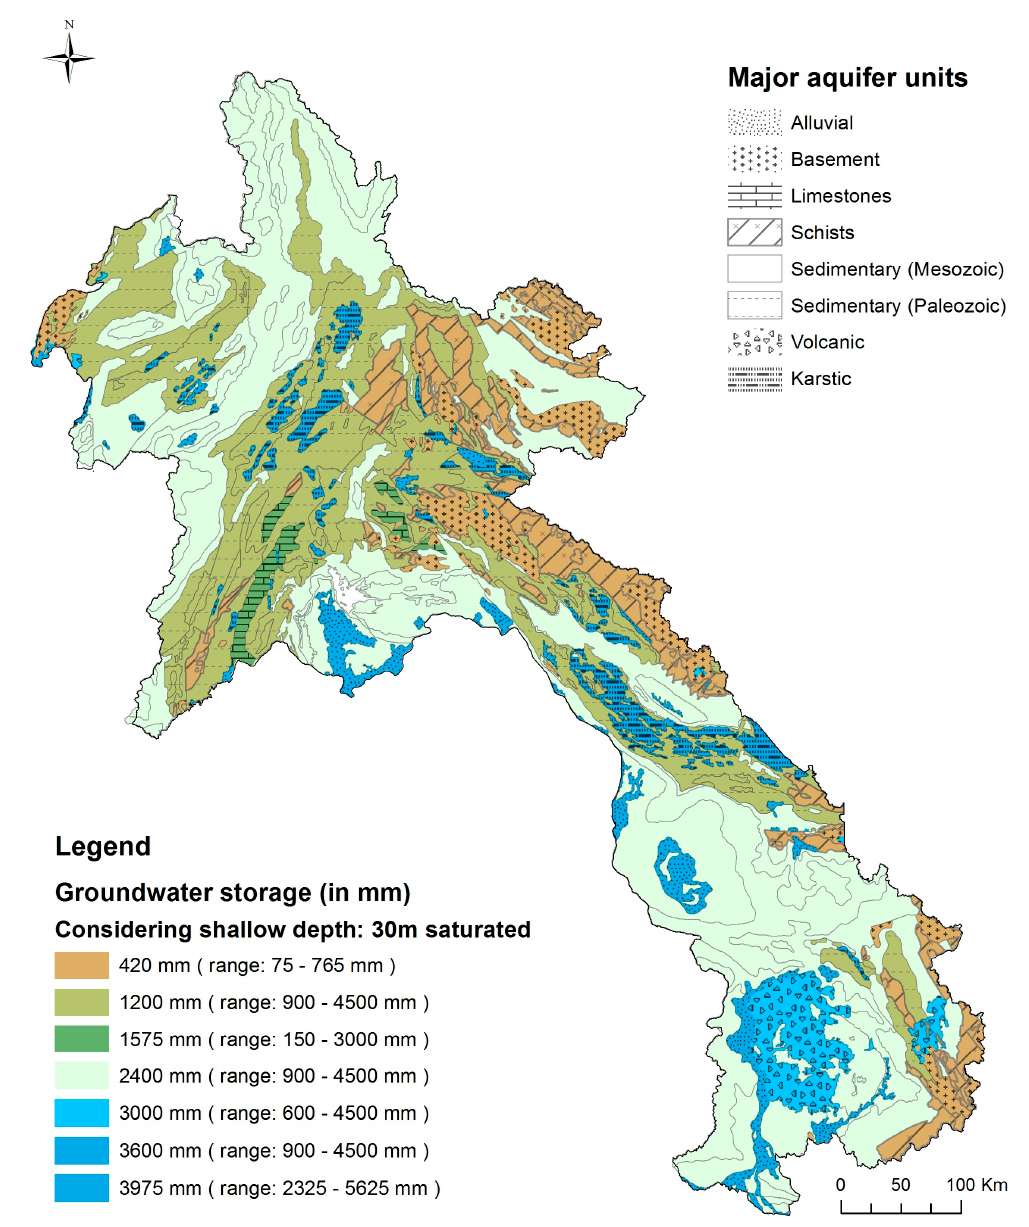
Figure 5. Map of shallow groundwater storage in Laos, considering a 30 m saturated thickness.